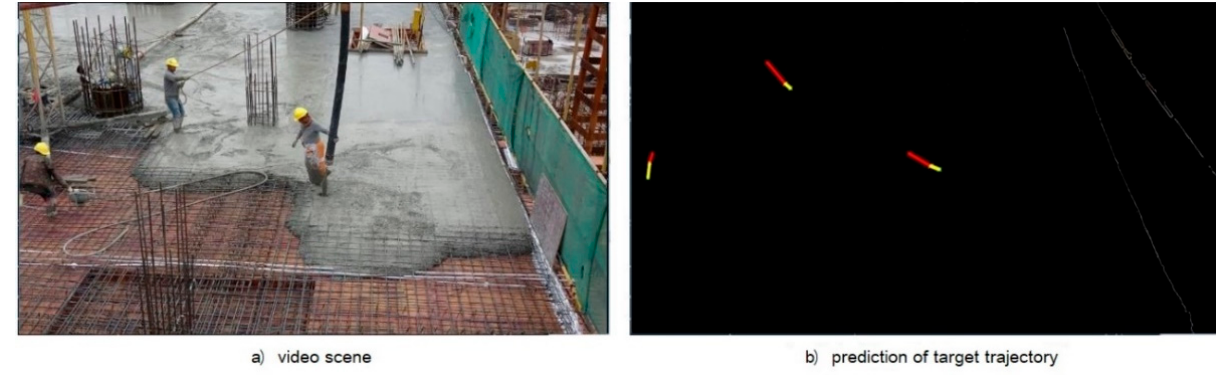
Figure 16. Field tracking effect.